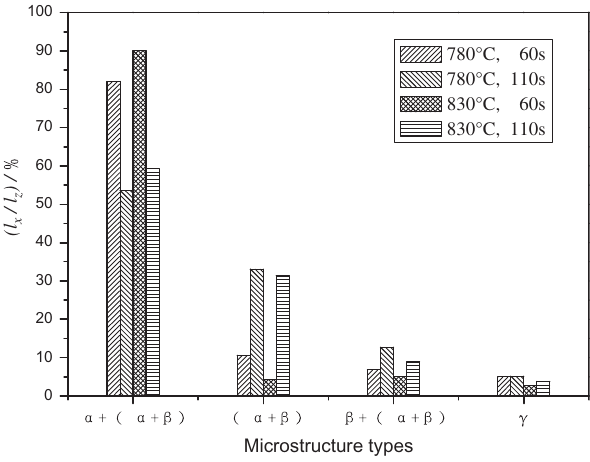
Figure 6: Proportion of the thickness of every kind of structure to the total thickness of transition layer l x – the thickness of every kind of structure; l γ / l z – 10 times of the actual value.